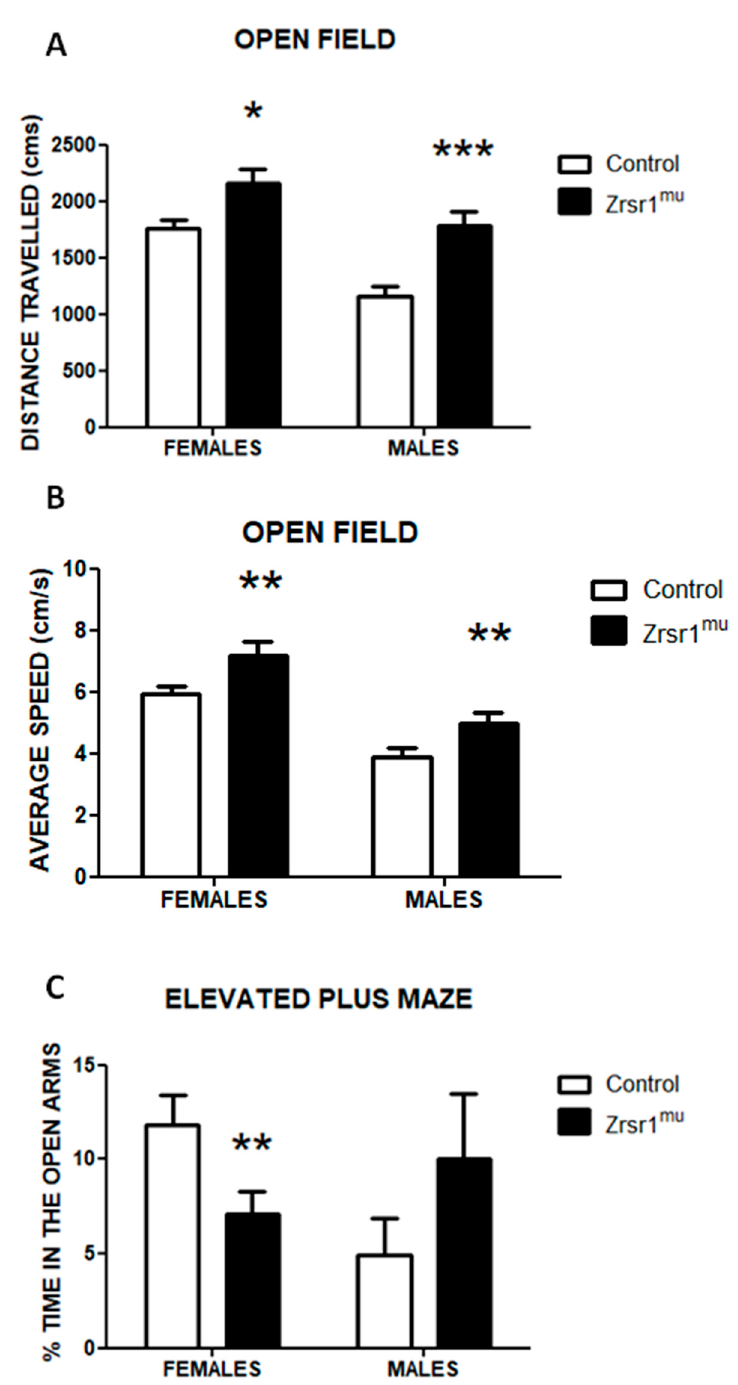
Figure 3. Performance in the open field test. Panel ( A ) represents total distance travelled, panel ( B ) represents average speed of movement of male and female wild-type (control) and Zrsr1 mu mice. Panel ( C ) represents anxiety in the elevated plus maze of male and female wild-type and Zrsr1 mu mice. Data are means ± SEM of at least 8 animals per group. * p < 0.05, ** p < 0.01, **** p < 0.001, 2-way ANOVA.